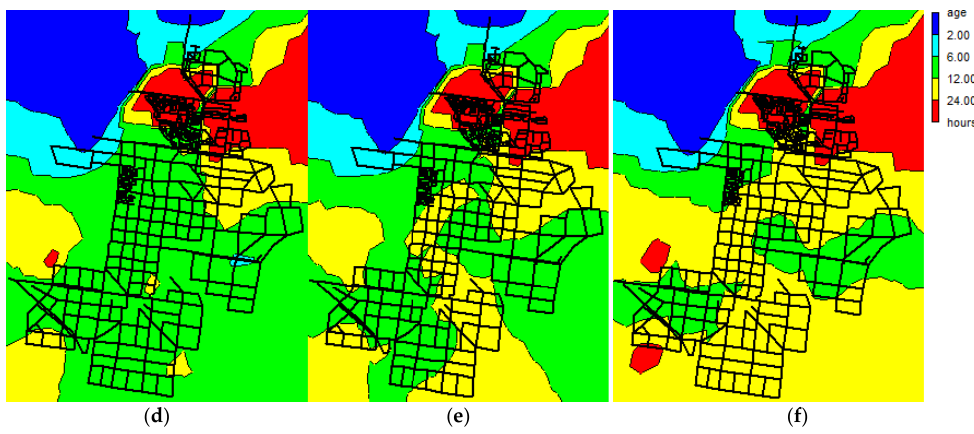
Figure 6. Pressure and water age distribution for the initial situation and the reduction scenarios: pressure distribution for the ( a ) initial situation; ( b ) RI; ( c ) WE and the residence time in the network ( d ) initial situation; ( e ) RI and ( f ) WE for the last day of a 10-day extended period simulation.